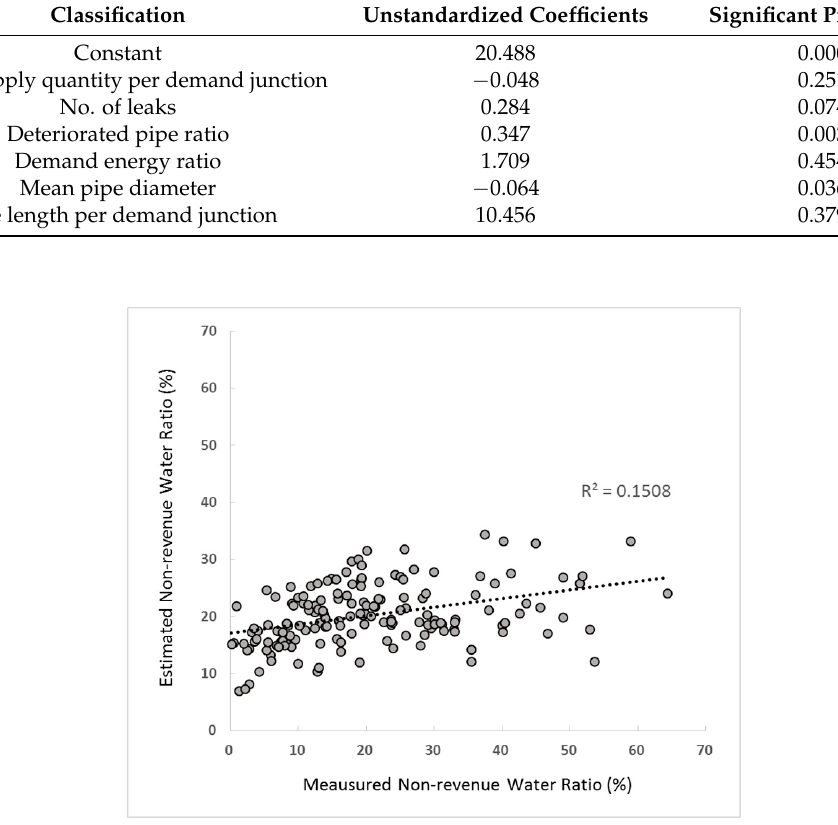
Figure 11. Scatter Plot of NRW Ratio Using MRA Results.